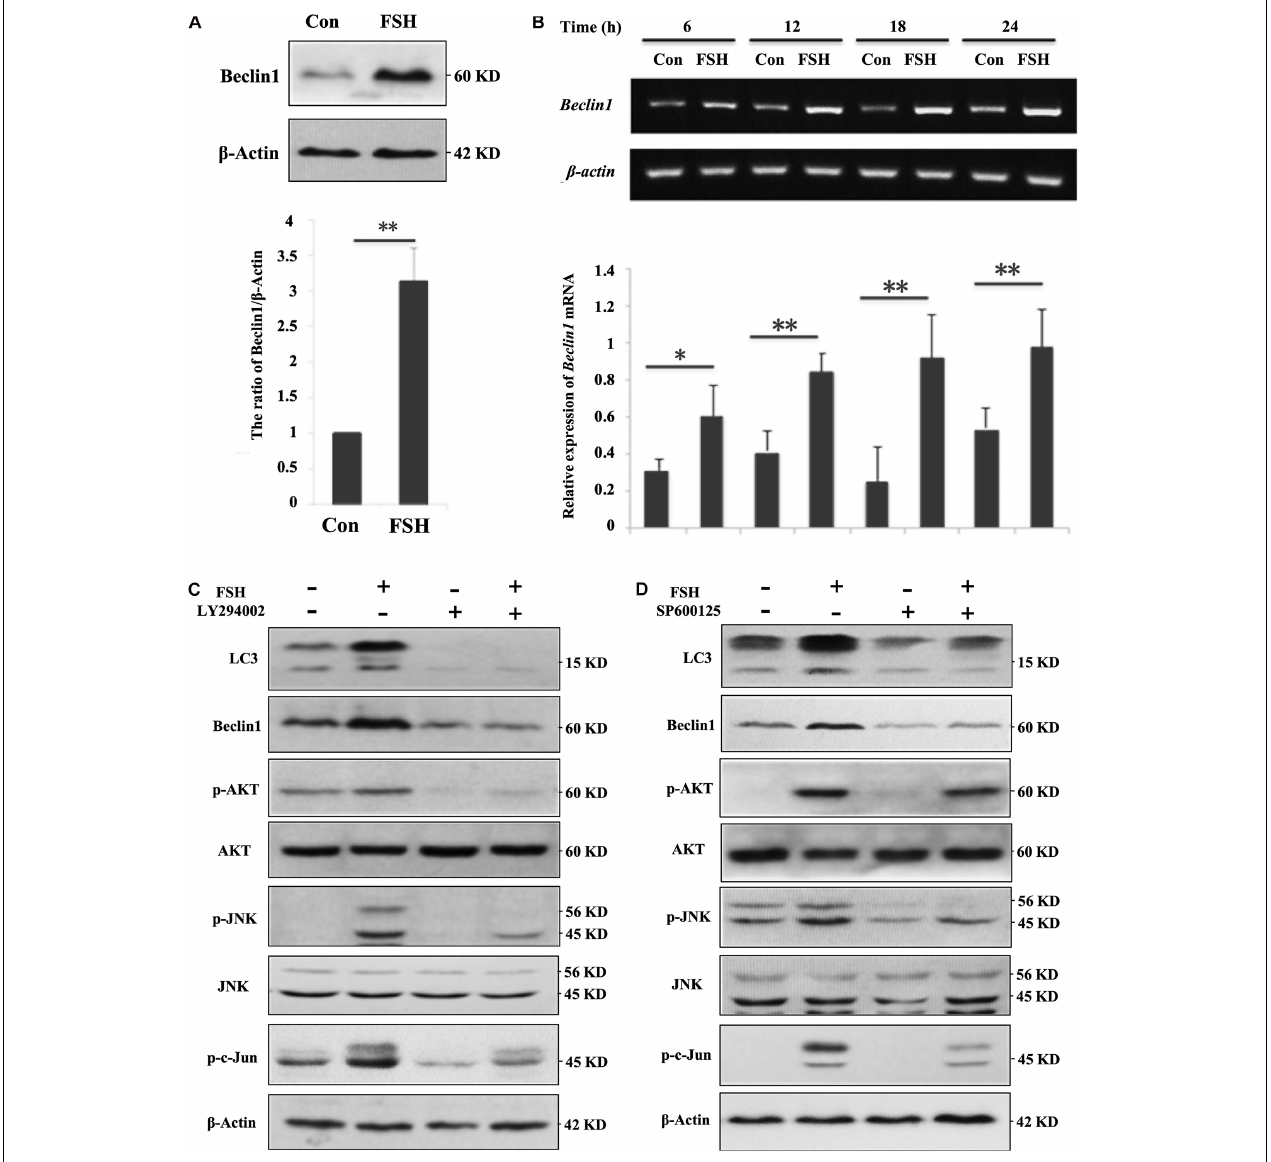
FIGURE 2 | FSH upregulates beclin1 expression in porcine GC mass via the PI3K/JNK/c-Jun pathway. (A) GC mass were cultured in DMEM/F12 medium containing 0.01 IU/mL FSH for 24 h, beclin1 and β -actin levels were detected by western blotting of the whole cell lysates. (B) GC mass were cultured in DMEM/F12 medium containing 0.01 IU/mL FSH for the indicated hours, and total RNA was collected for cDNA synthesis. Expression of beclin1 and β -actin mRNA was measured by PCR assay. (C) GC mass were pre-treated with LY294002 (10 µ M, inhibitor of PI3K/AKT signaling pathway) for 1 h before stimulation with 0.01 IU/mL FSH for 24 h, p-AKT, AKT, p-JNK, JNK, p-c-Jun, Beclin1, and β -actin levels were detected in whole cell lysates. (D) GC mass were pre-treated with SP600125 (10 µ M, inhibitor of SAPK/JNK signaling pathway) for 1 h before stimulation with 0.01 IU/mL FSH for 24 h, p-AKT, AKT, p-JNK, JNK, p-c-Jun, Beclin1, and β